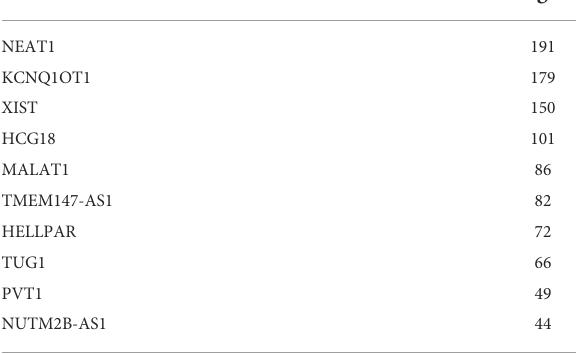
TABLE 1 The top 10 LncRNAs for degree on the network in control group.